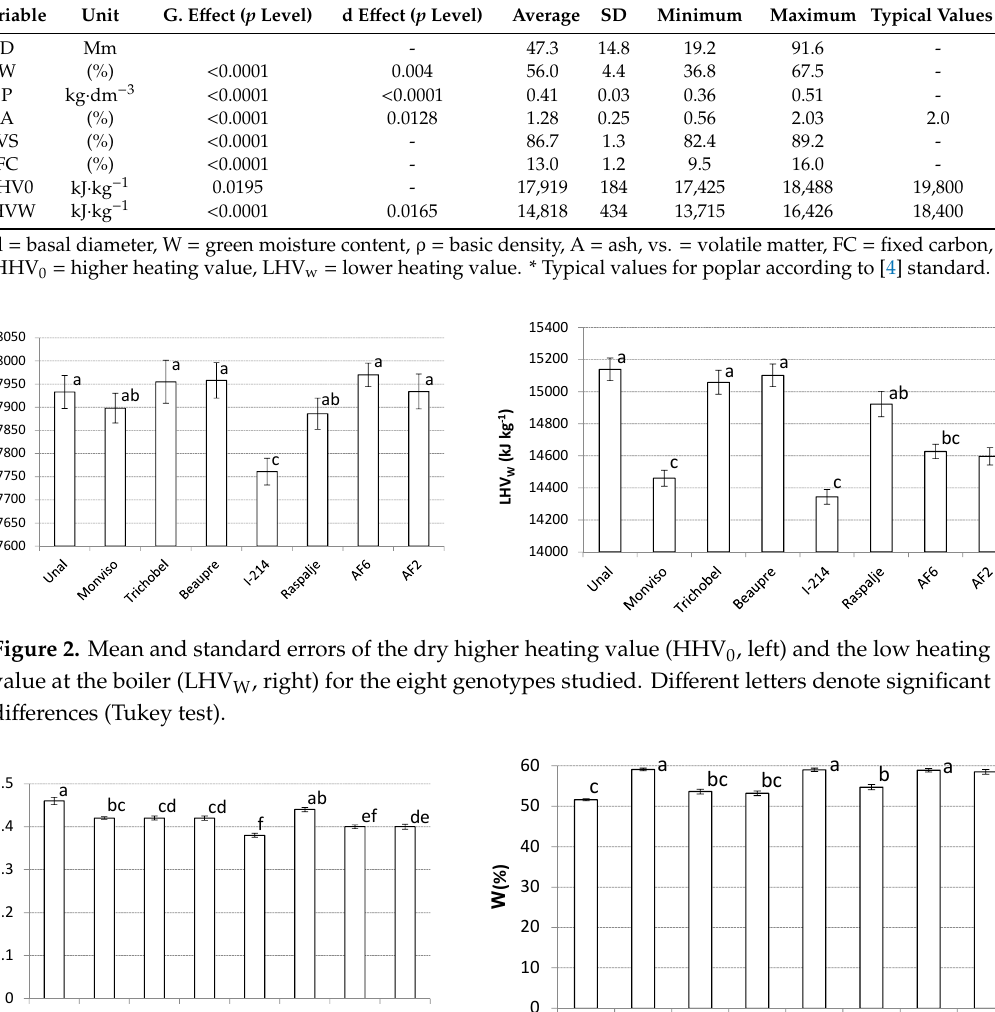
Table 2. Results of the ANCOVA and descriptive statistics for the energy properties evaluated. G refers to genotype effect. SD stands for standard deviation.